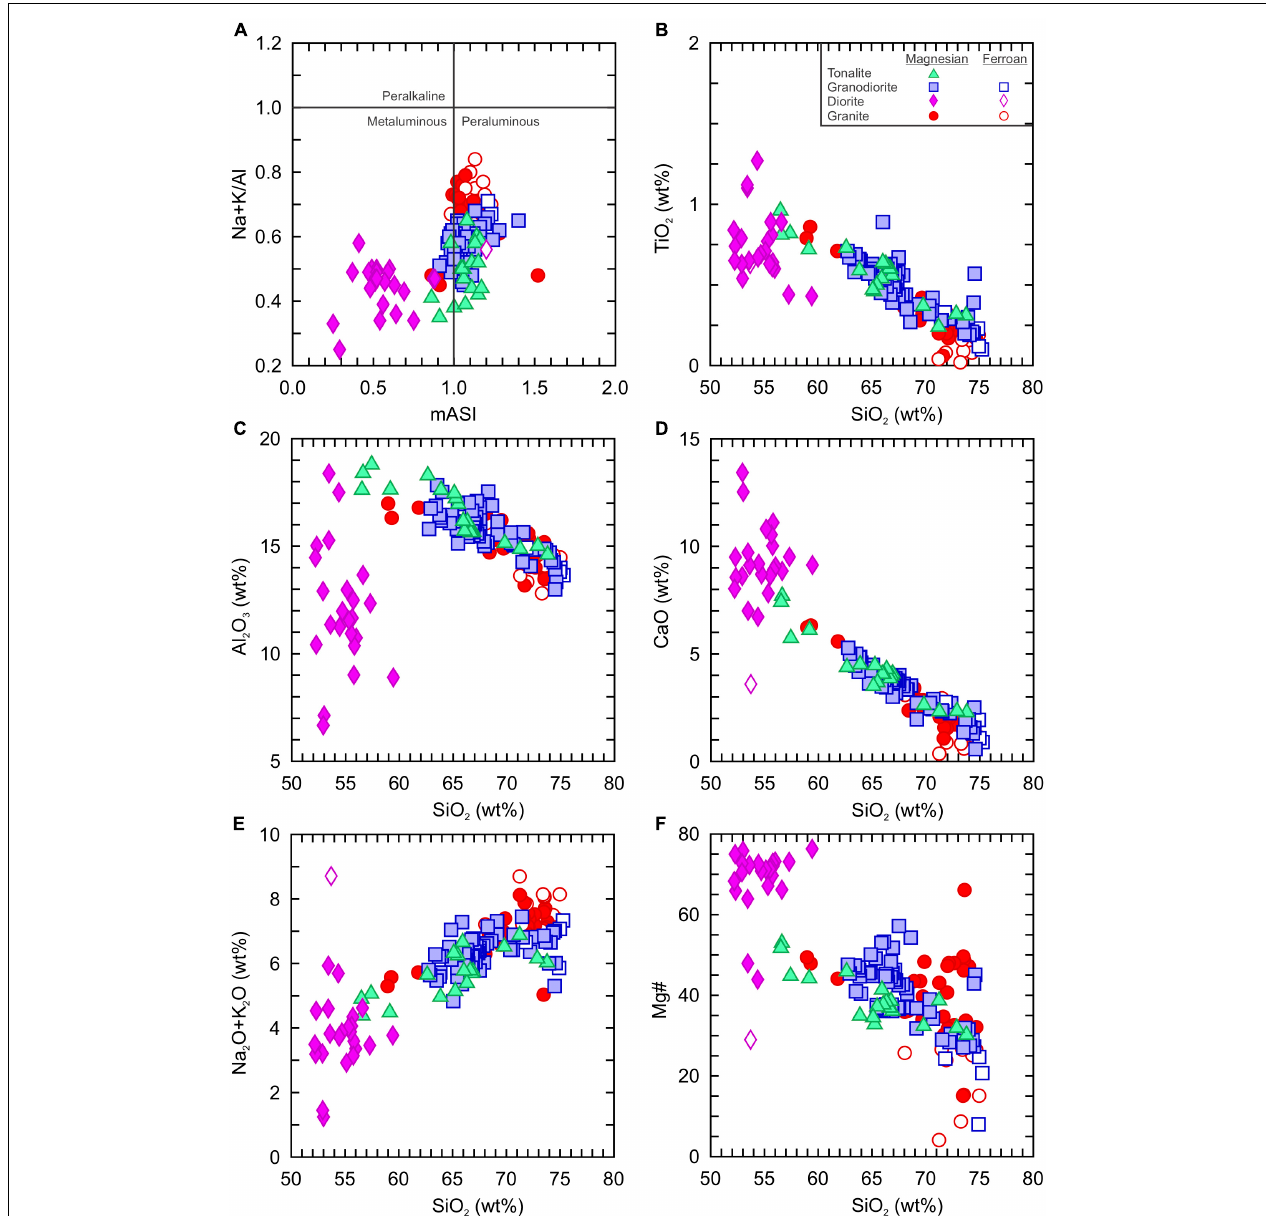
FIGURE 4 | Major element variation of the Cretaceous granites, granodiorites, tonalites, and diorites from Kyushu. (A) Alumina saturation index [mASI = molecular Al/(Ca − 1.67P + Na + K)] vs. alkali-alumina ratio [molecular (Na + K)/Al]. (B) TiO 2 (wt%) vs. SiO 2 (wt%). (C) Al 2 O 3 (wt%) vs. SiO 2 (wt%), (D) CaO (wt%) vs. SiO 2 (wt%). (E) Na 2 O + K 2 O (wt%) vs. SiO 2 (wt%). (F) Mg# [molecular Mg/(Mg + Fe)*100] vs. SiO 2 (wt%). The division of rocks into magnesian and ferroan is plotted in Figure 2